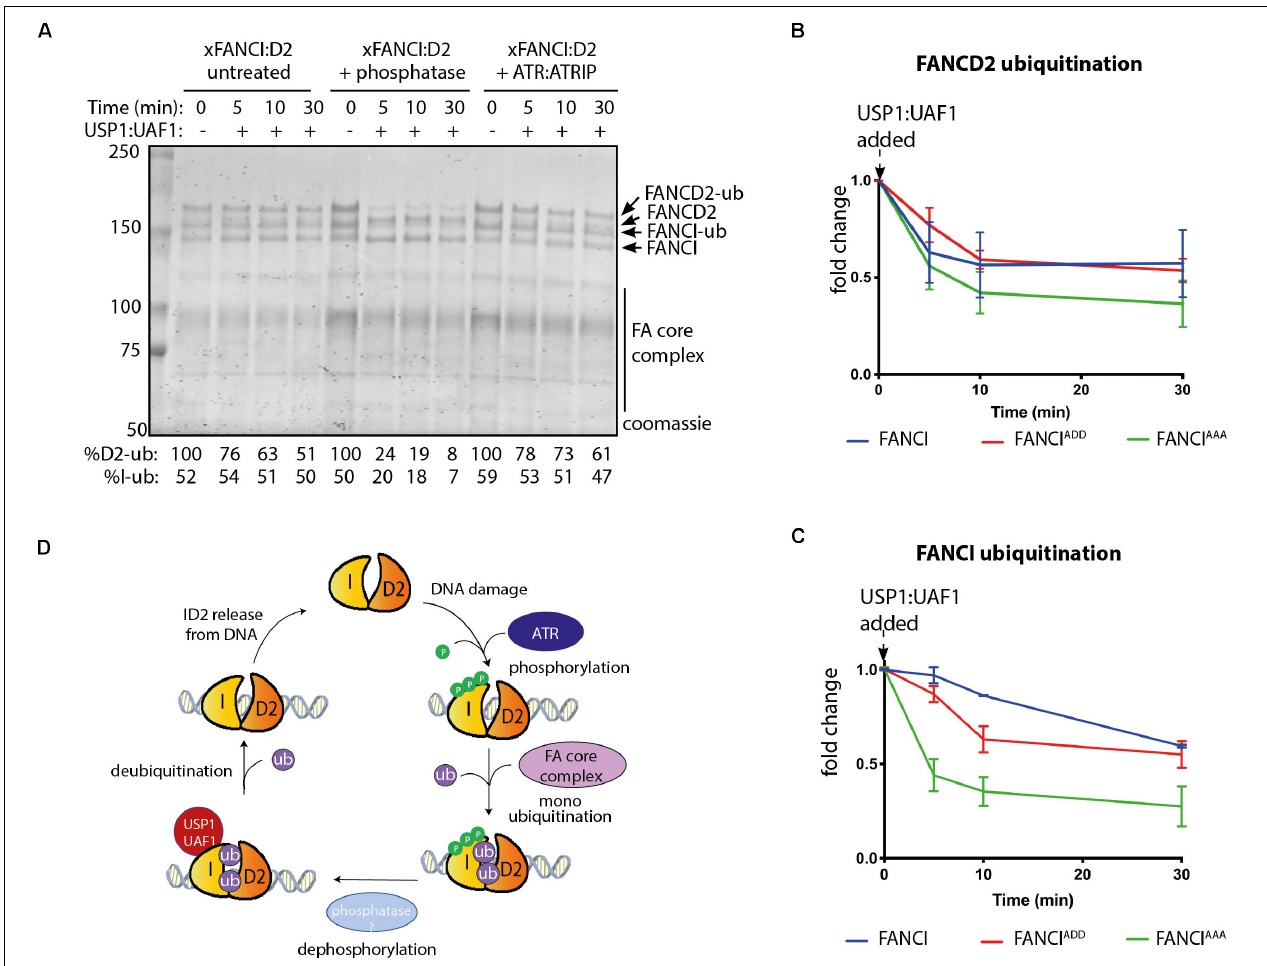
FIGURE 4 | FANCI dephosphorylation as a switch to turn off FANCLFANCD2 deubiquitination. (A) Coomassie stained SDS-PAGE showing the deubiquitination time course of untreated, phosphatase and ATR-ATRIP treated Xenopus FANCLFANCD2 complexes. (B) Graphical representation of FANCD2 or (C) FANCI ubiquitination fold change after USP1:UAF1 is added within the FANCI WT :FANCD2, FANCI ADD :FANCD2 and FANCI AAA :FANCD2 complexes (representative experiment of n = 3). (D) Model of the role of FANCI phosphorylation in regulating FANCL:FANCD2 monoubiquitination and deubiquitination.